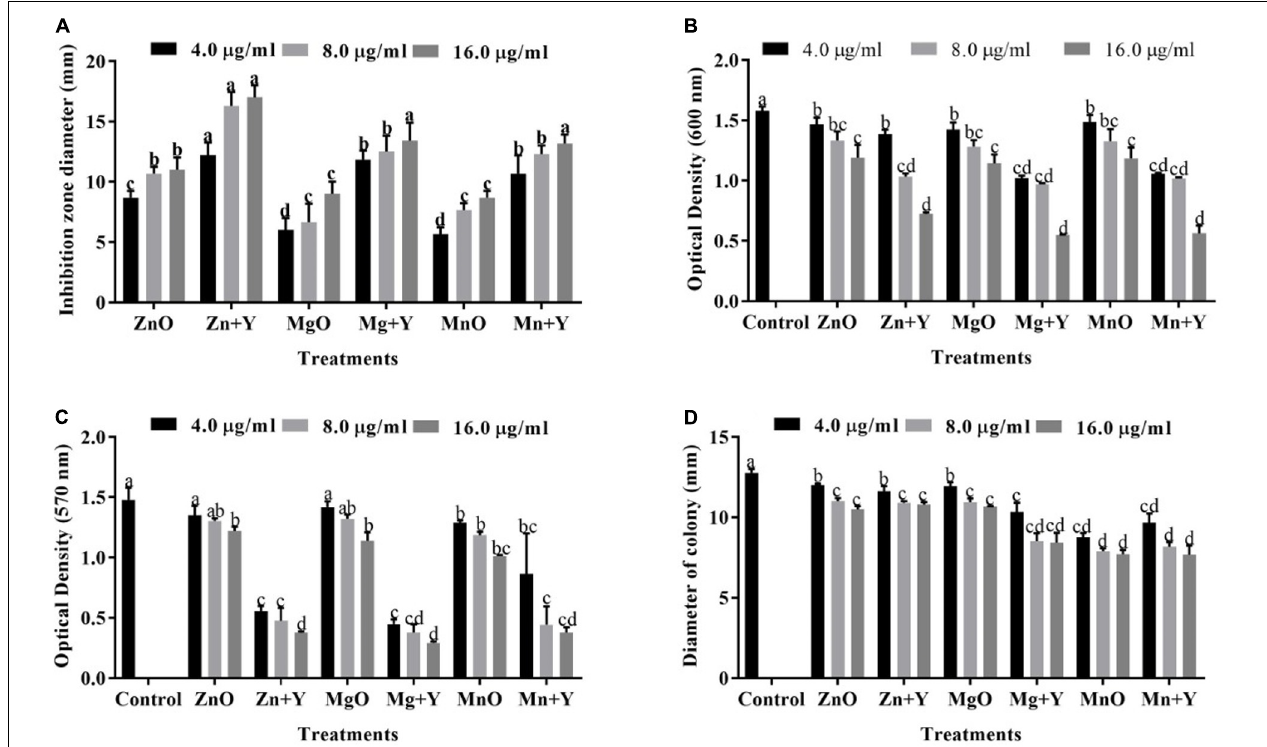
FIGURE 5 | (A) Inhibitory effect of bulk metal oxide and nanoparticles. (B) Effect of the bulk metal oxide and nanoparticles on bacterial growth. (C) Effect of the bulk metal oxide and nanoparticles on biofilm formation. (D) Effect of the bulk metal oxide and nanoparticles on the swarming motility of Xoo strain GZ 0006. Zn + Y, ZnO